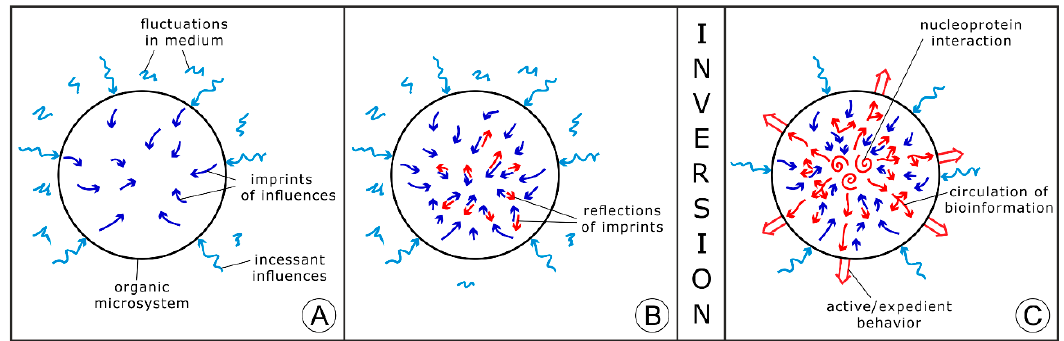
Figure 3. The scheme of conversion of a nonequilibrium prebiotic microsystem into the primary form of life under oscillating conditions. ( A ) The rise (self-assembly) of an organic prebiotic microsystem within the oscillating medium; the penetration of continuous external influences into the microsystem and the transformation of the network of chemical reactions (blue arrows); ( B ) the initiation of the system’s response to continuous external stress, arising of the chemical reactions counteracting the stress and partially compensating it; ( C ) the conversion of the prebiotic microsystem in the initial form of life when its activity (counteraction) exceeds the pressing from the oscillating environment. The conversion corresponds to the thermodynamic inversion.